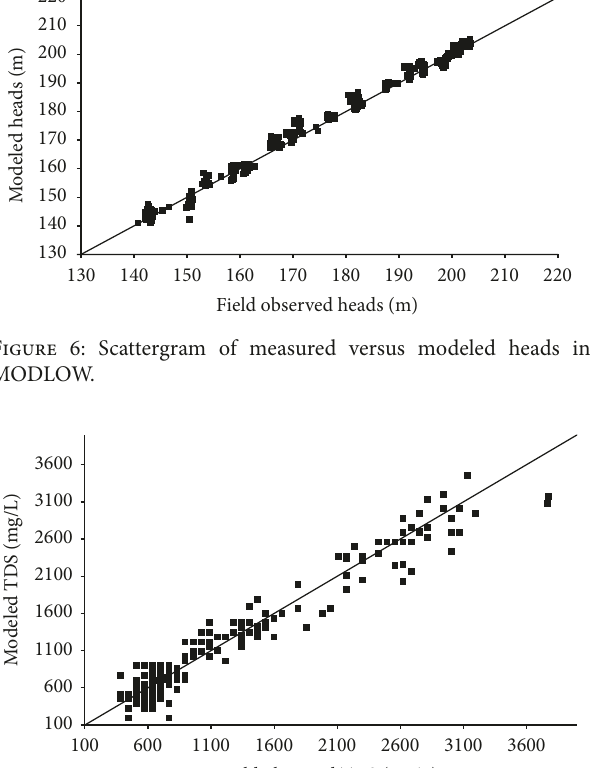
Table 2: Statistical analysis of the field and modeled data.